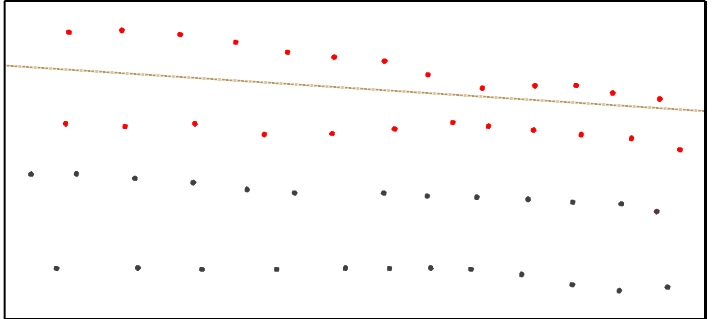
Figure 3. Control points located in the first sector. Brown line corresponds to the path. Black points are high precision GPS VRS antenna and red points are low precision magnetometer GPS antenna. The dimensions are 2.75 x 1.25 meters.